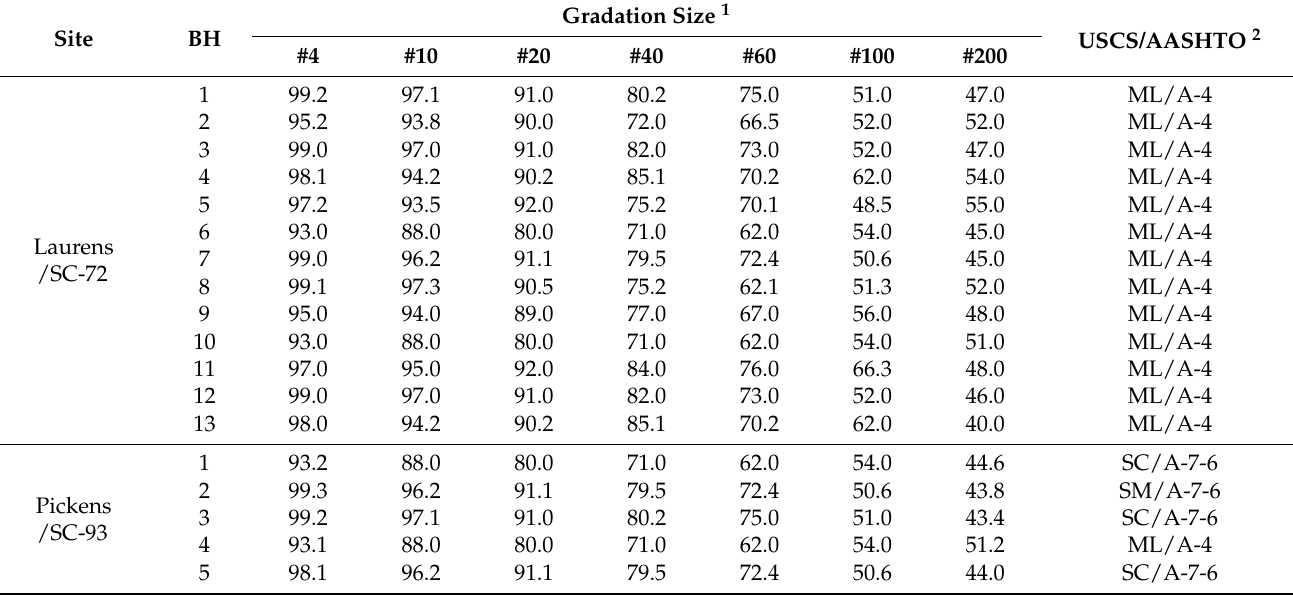
Table 6. Soil classification and gradation for 18